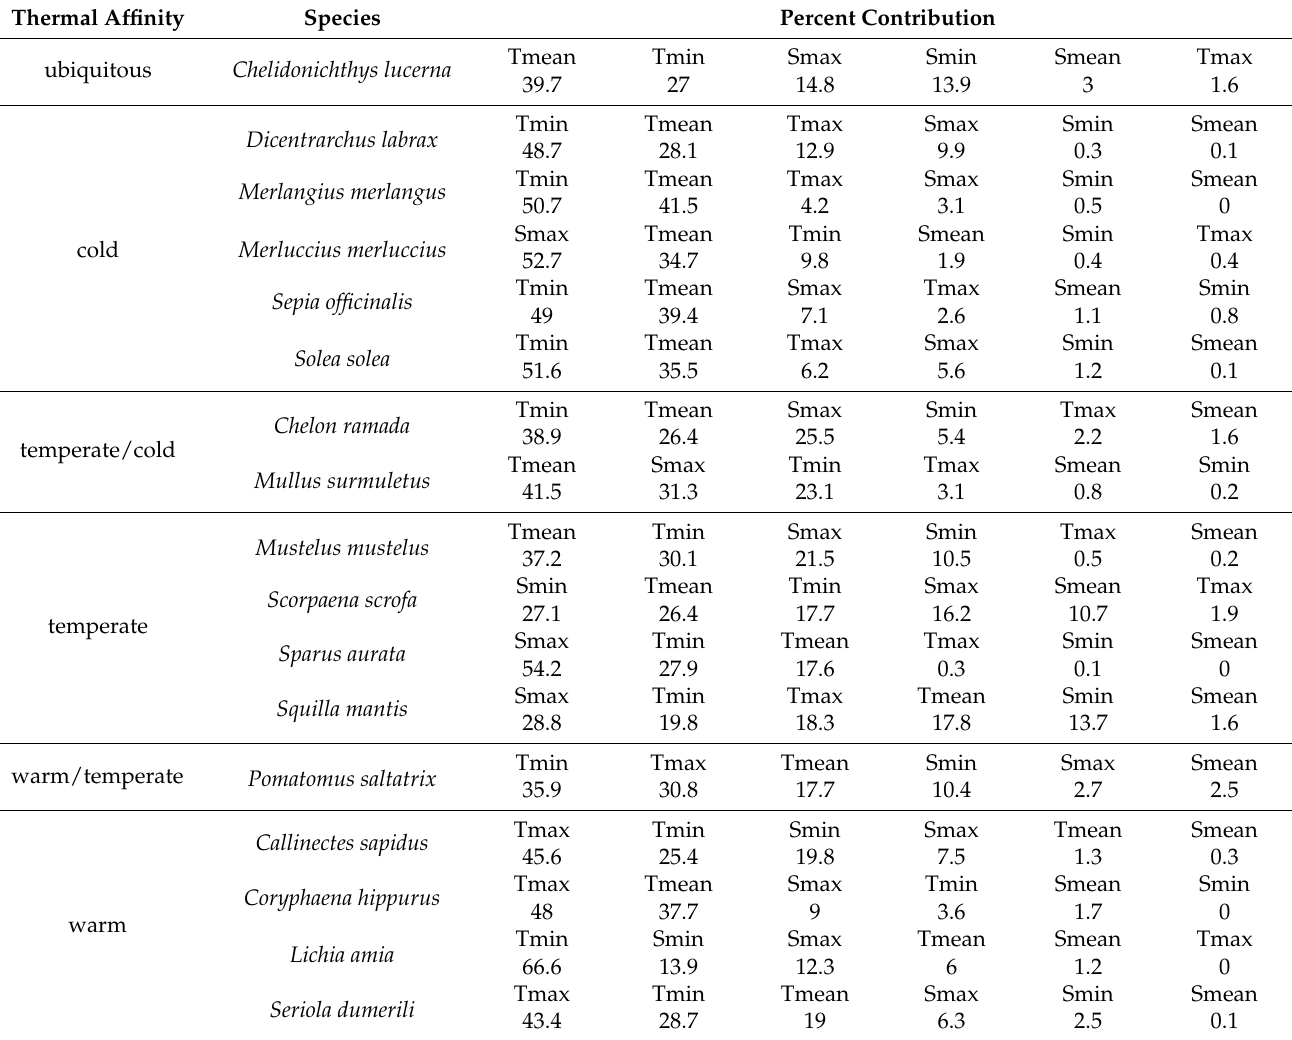
Table 3. Estimates of relative percentage contributions of the environmental variables to the MaxEnt